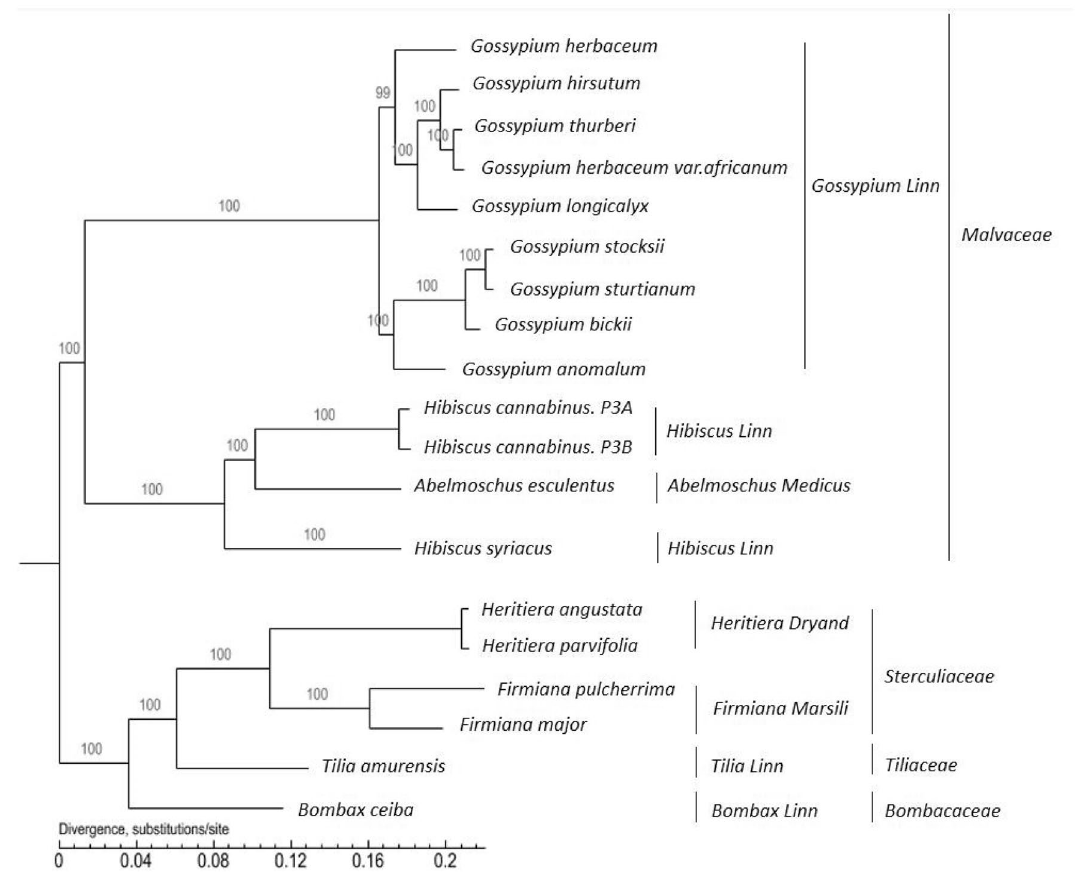
Figure 5. Molecular phylogenetic tree of 19 species of